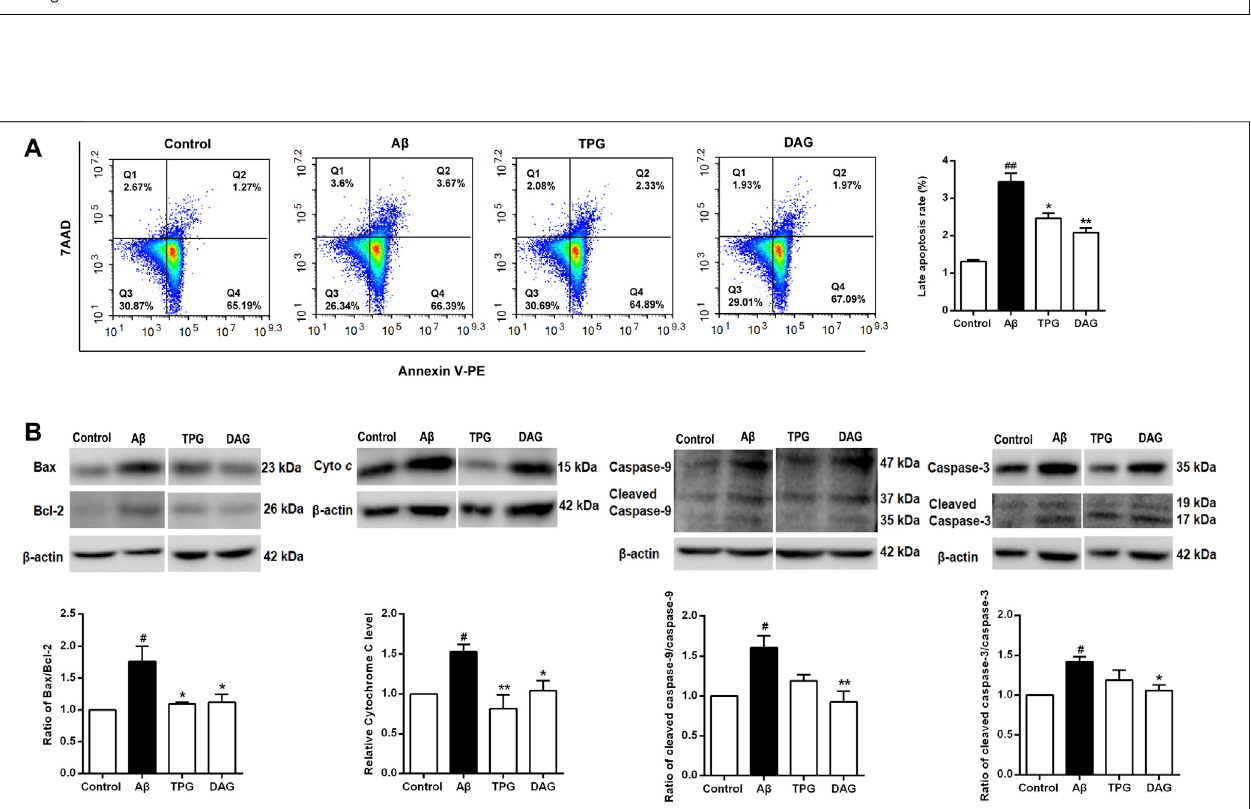
FIGURE 8 | The regulation of TPG and DAG on the cell apoptosis (A) The apoptotic cell was measured by fl ow cytometry. Late apoptotic cell rate was detected in different groups after 20 h pre-treatment with the four drugs and a subsequent 4 h incubated with A β 25 – 35 (B) The expression levels of pro-apoptosis proteins were detected using western blot. All values were shown as mean ± SEM from three independent studies. Statistical analyses were performed using one-way ANOVA and Tukey-HSD post hoc comparisons. p # < 0.05, vs. control group; * p ＜ 0.05, vs. A β 25 – 35 models; ** p ＜ 0.01, vs. A β 25 – 35 models. Cyto c, Cytochrome c; TPG, tortoise plastron gelatin; DAG, deer antler